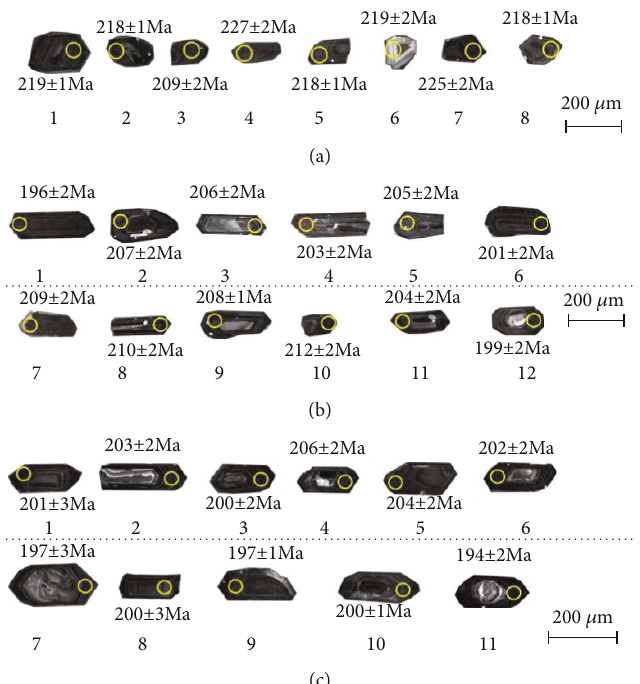
Figure 8: The zircon cathodoluminescence (CL) images ((a) 3250-41Lb1, (b) 3250-41Lb2, and (c) 45-R4) from the granite porphyries in Yangla copper deposit, Yunnan,